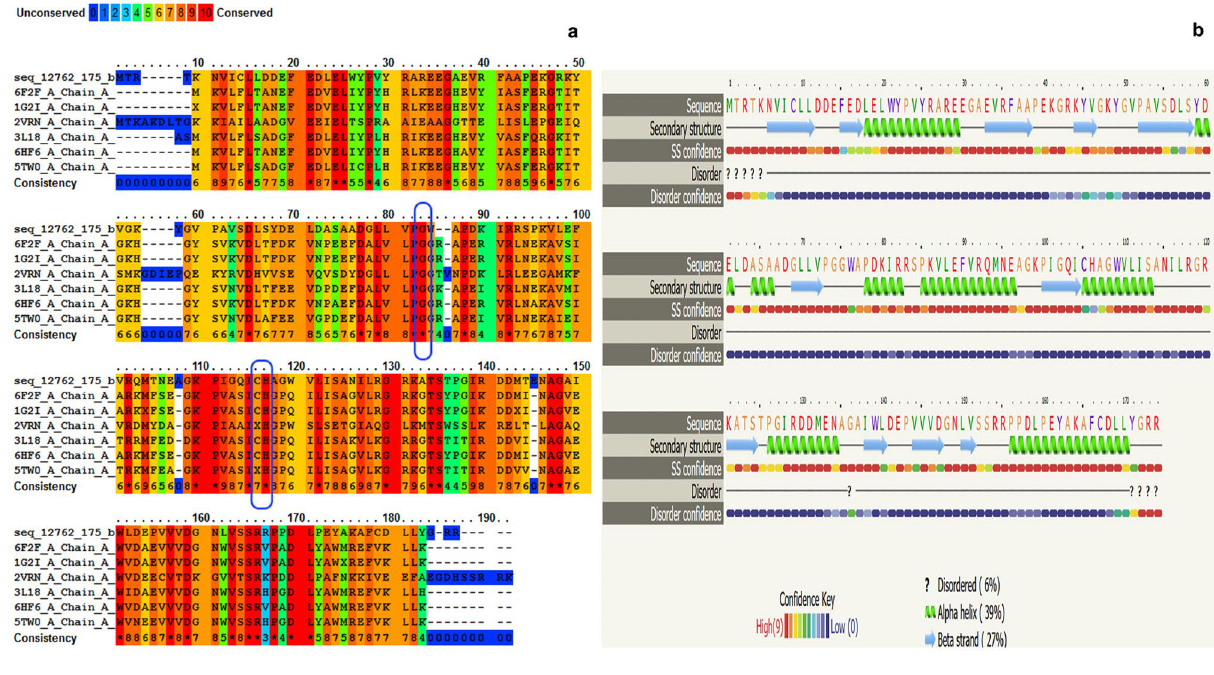
Figure 2. ( a ) Protein sequence alignment of rEla and six closely related sequences. Boxed regions show conserved active site residues. ( b ) Secondary structure of rEla using Phyre2 program. The protease had 39% alpha helix, 28% random coils, 27% beta strand and 6% disordered